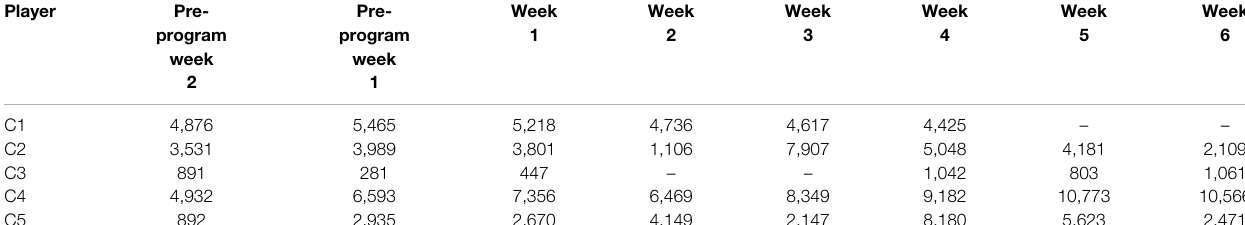
TABLE 3 | Weekly steps measured by the Garmin Vivo fi t Jr. activity tracker. The children were asked to wear the tracker for the 2 weeks prior to start of the study, and the 6 weeks of the study. Player